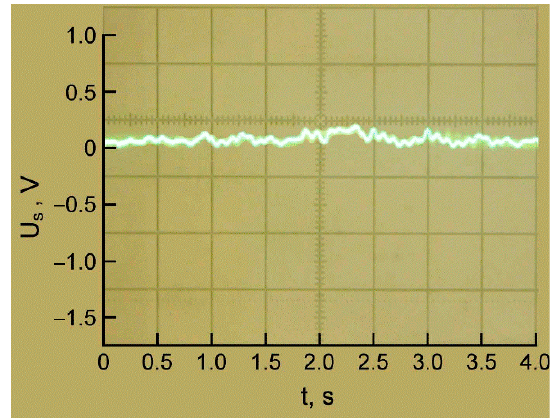
Figure 5. Shape of NMR signal lines at the output of registration circuit 11 from feed water with inversion of magnetization at f n = 1,441,278 Hz, H 1 = 14.7 A/m, H m = 31.1 A/m, f m = 3127 Hz.